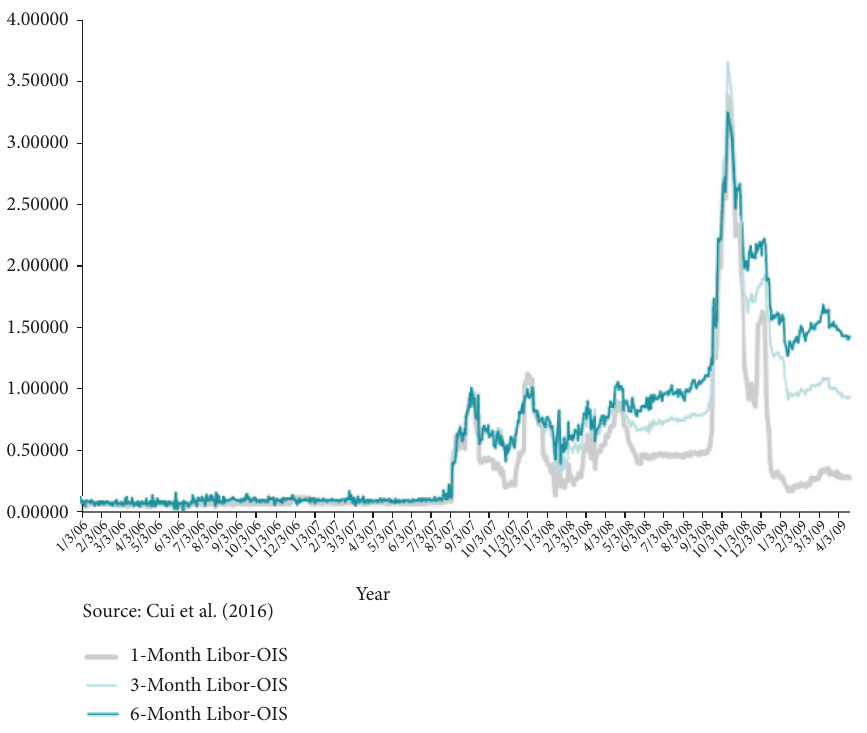
Figure 2: Different Tenor USD LIBOR-OIS